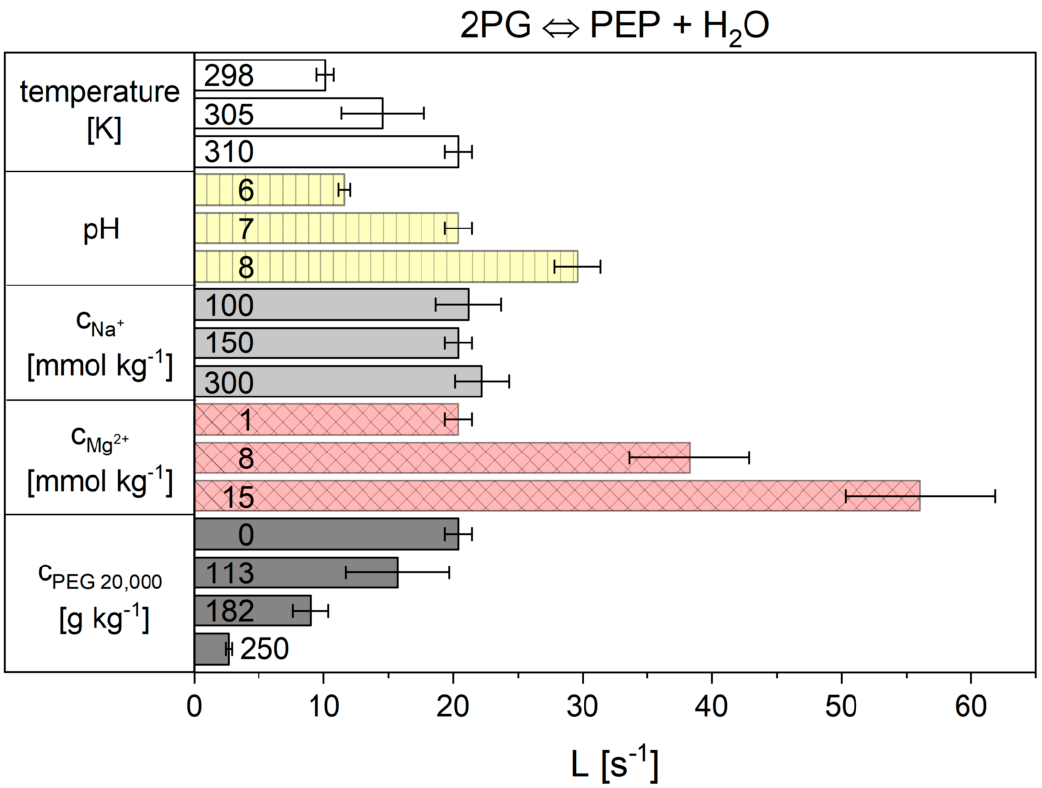
Figure 8. Influence of the di ff erent cytosolic conditions on the kinetic parameter of reaction 9 of the flux-force model.